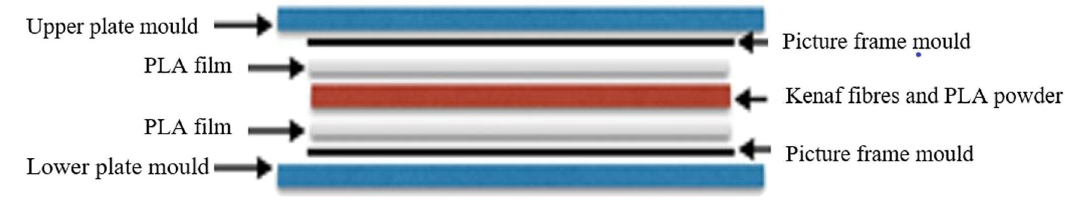
Figure 1: Schematic illustration of composite arrangement during hot press